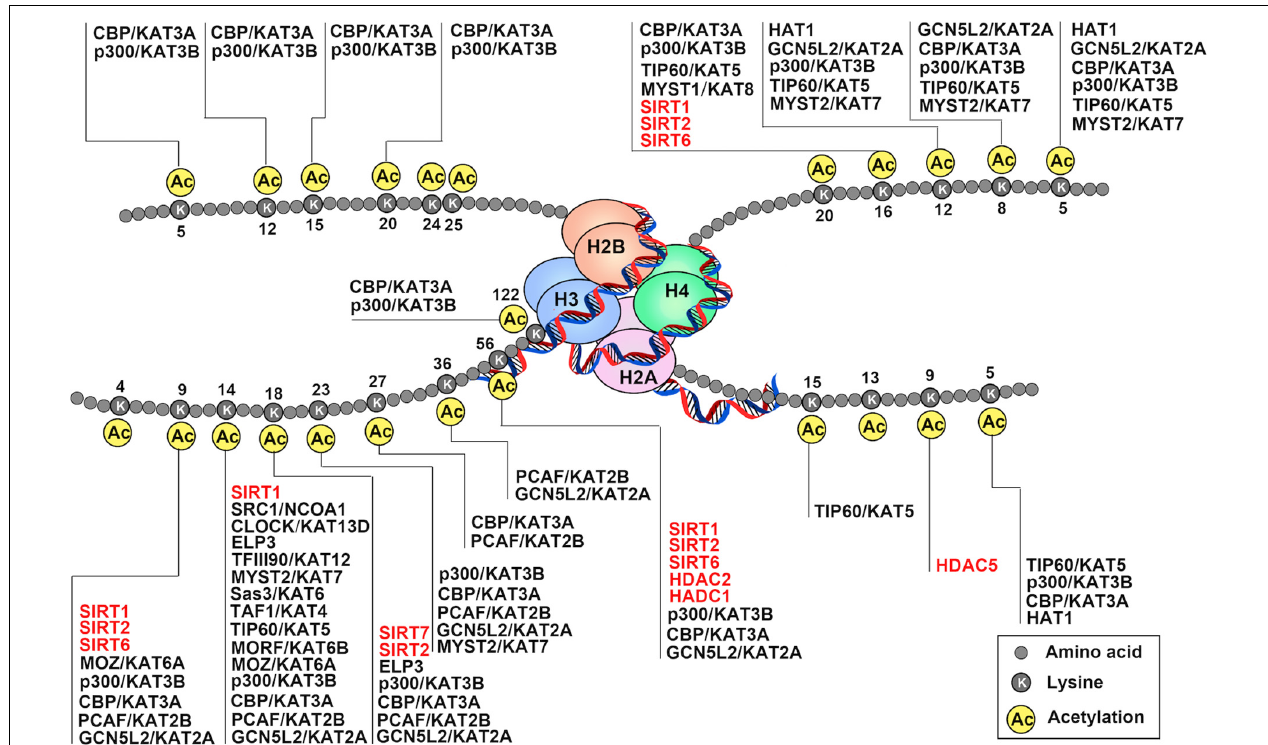
FIGURE 1 | Schematic drawing of histone acetylation. DNA is wound around nucleosomes, which are composed of eight histone molecules with two copies of histones H2A, H2B, H3, and H4. Each histone molecule has a long tail rich in lysine residues (K), which are acetylation modification sites. Gene activation and repression are regulated by acetylation of core histone, and histone acetylation is mediated by coactivators (histone acetyltransferase: HATs) and corepressors (histone deacetylases: HDACs). The addition of acetyl-groups to the tails of histone core proteins leads to a relaxing state of chromatin and includes active transcription. In turn, removel of acetyl-groups from the tails of histone core proteins leads to the adoption of a condensed state of chromatin and transcriptional